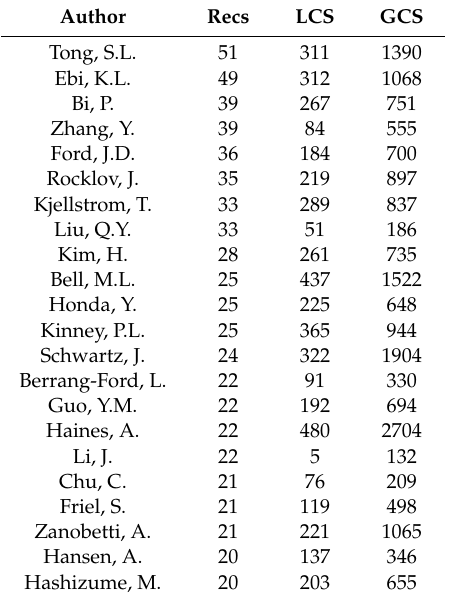
Table 3. Authors with 20 or more published